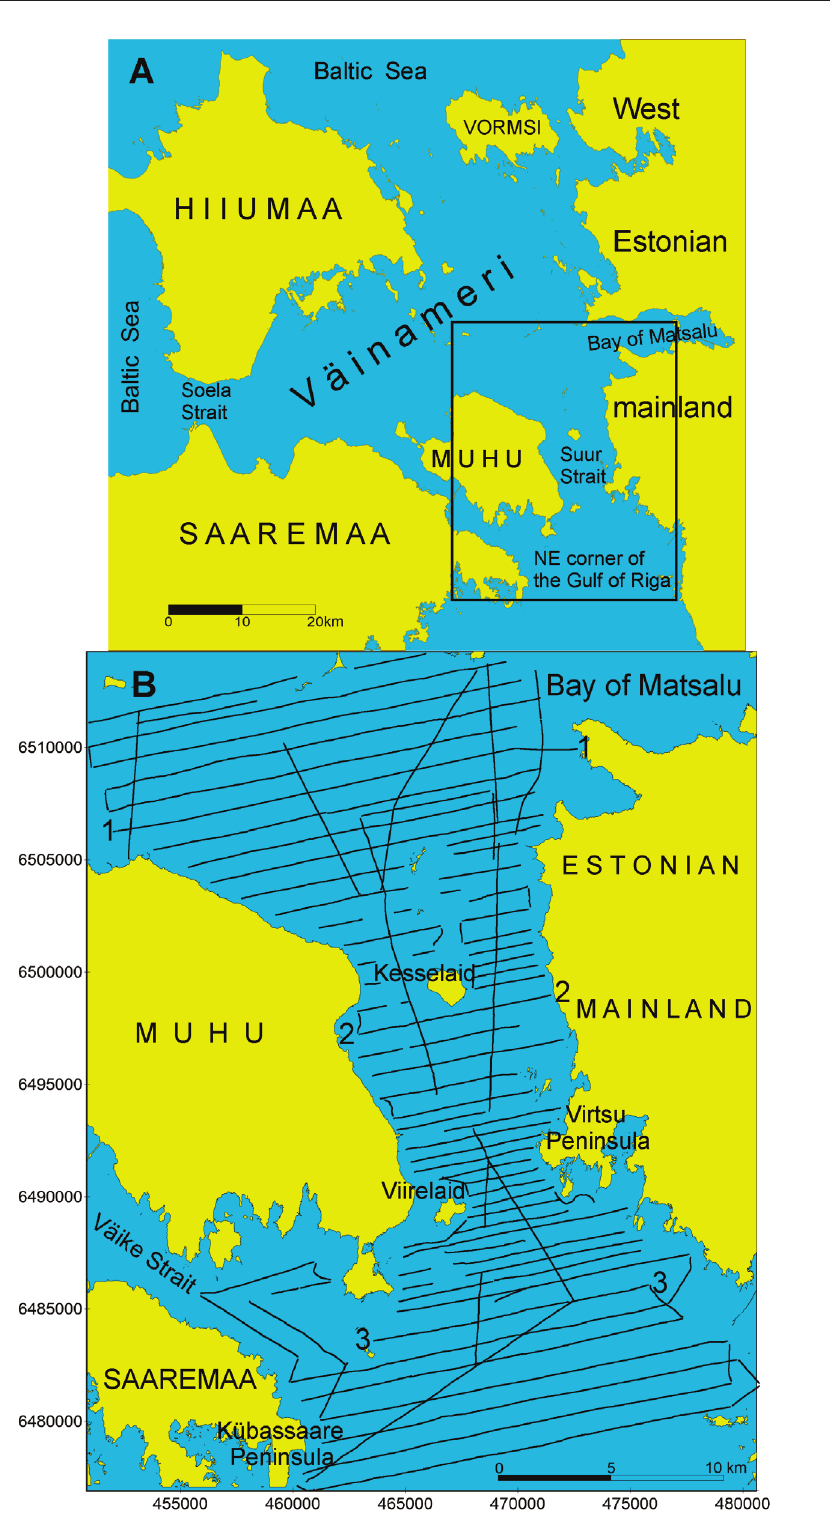
Fig. 1. (A) Väinameri in the West Estonian Archipelago with the framed study area; (B) Enlarged study area (marked with the Estonian Coordinate System 1997-EPSG:3301), showing the set/sections of the seismic lines providing bedrock surface data used in the compilation of the maps and 3D model (Figs 4, 5, 10). Numbered profiles 1–3 indicate locations of the seismic lines shown in Figs 2, 7,